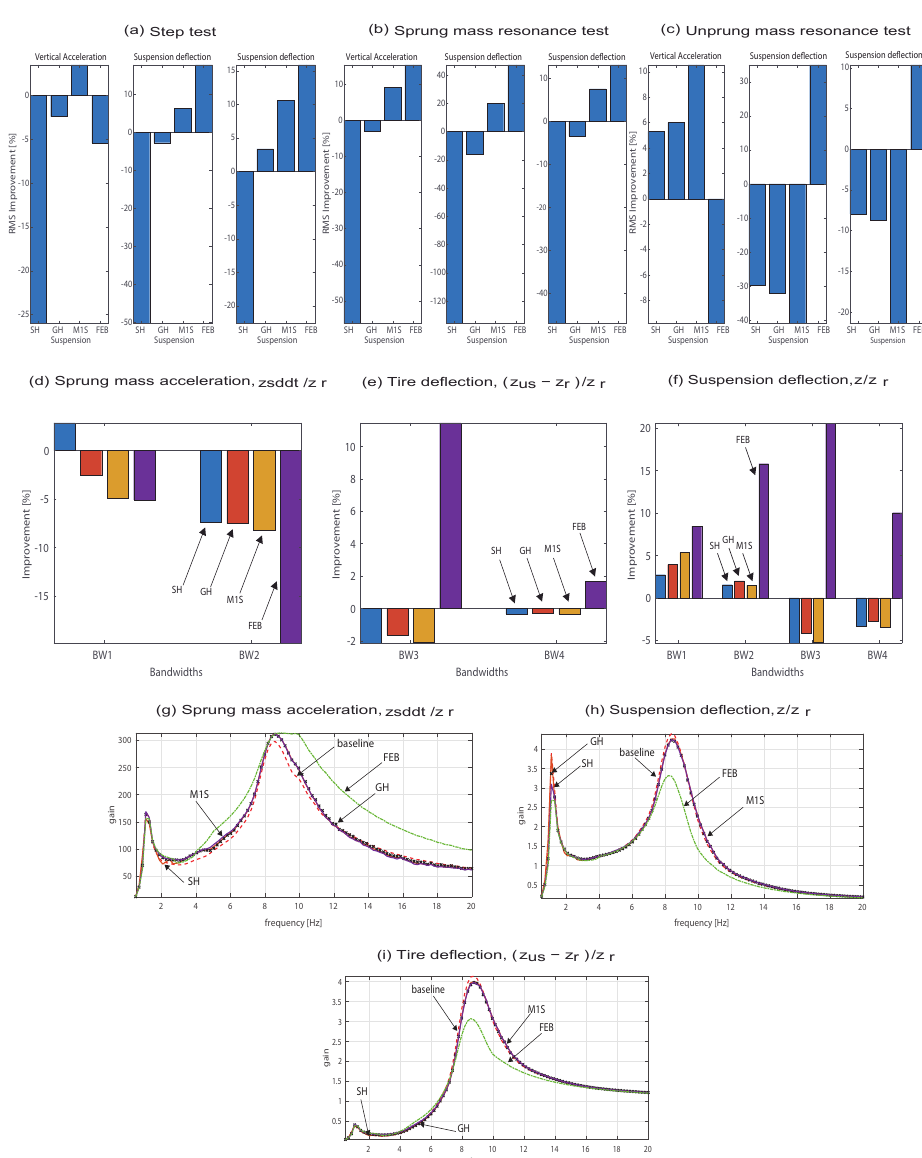
Figure 17. Results from closed simulations for the comparison in a nonlinear modified QoV model considering a 1.25 A baseline